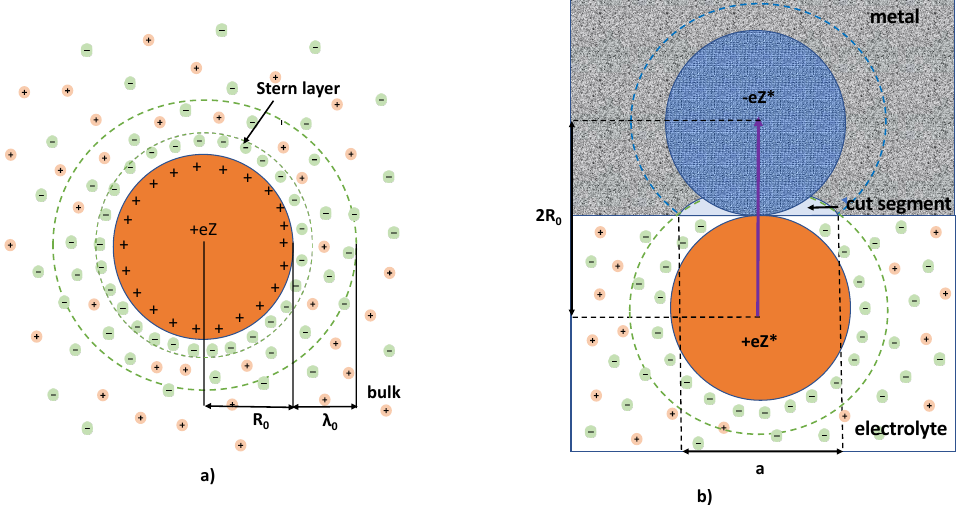
Figure 1. The schematic presentation of the multiply-charged colloidal particle surrounded by the cloud of counterions: ( a ) in the bulk of electrolyte; ( b ) in the vicinity of electrolyte–metal interface. In ( a ) is presented the standard scheme of the colloid structure assumed in the DLVO theory. Its core of the radius R 0 carries the charge eZ , while λ 0 appears in the DLVO theory as the characteristic screening length. The “Stern layer” is the auxilary characteristics of the screening coat, which is determined in the early theories [22,23], as the size of the region of elevate electrostatic energy [( R + λ ) 3 − R 3 ] possesses the opposite charge e ϕ (cid:29) k B T . The screening coat of the volume 4 π 0 0 0 3 − eZ . Hence, the entire colloidal particle in the DLVO model is neutral. In ( b ), the colloidal particle is schematically shown in contact with the electrode (metallic plane). Here, the counterions previously contained in the spherical segment partially leave the coat (see b ). This process results in acquisition by the colloidal particle of the effective charge eZ ∗ (see Equation (8)), which, together with its mirror image, creates the electric dipole. Note that the effective charge considered here is that of static colloidal particles, to be distinguished from the dynamic effective charge of moving particles